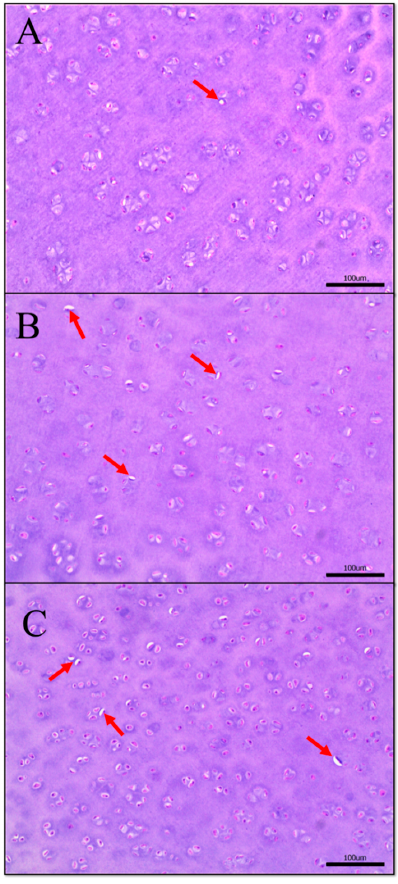
Figure 4. Hematoxylin and eosin (H&E) staining of chondrocytes in the femoral head articular cartilage (scale bar: 100 μ m). ( A ) H&E stained histological section of the normal femoral head in group C. Histological section of the femoral head cartilage in group L ( B ) and group H ( C ). The area where the red arrow points is an empty lacunae.